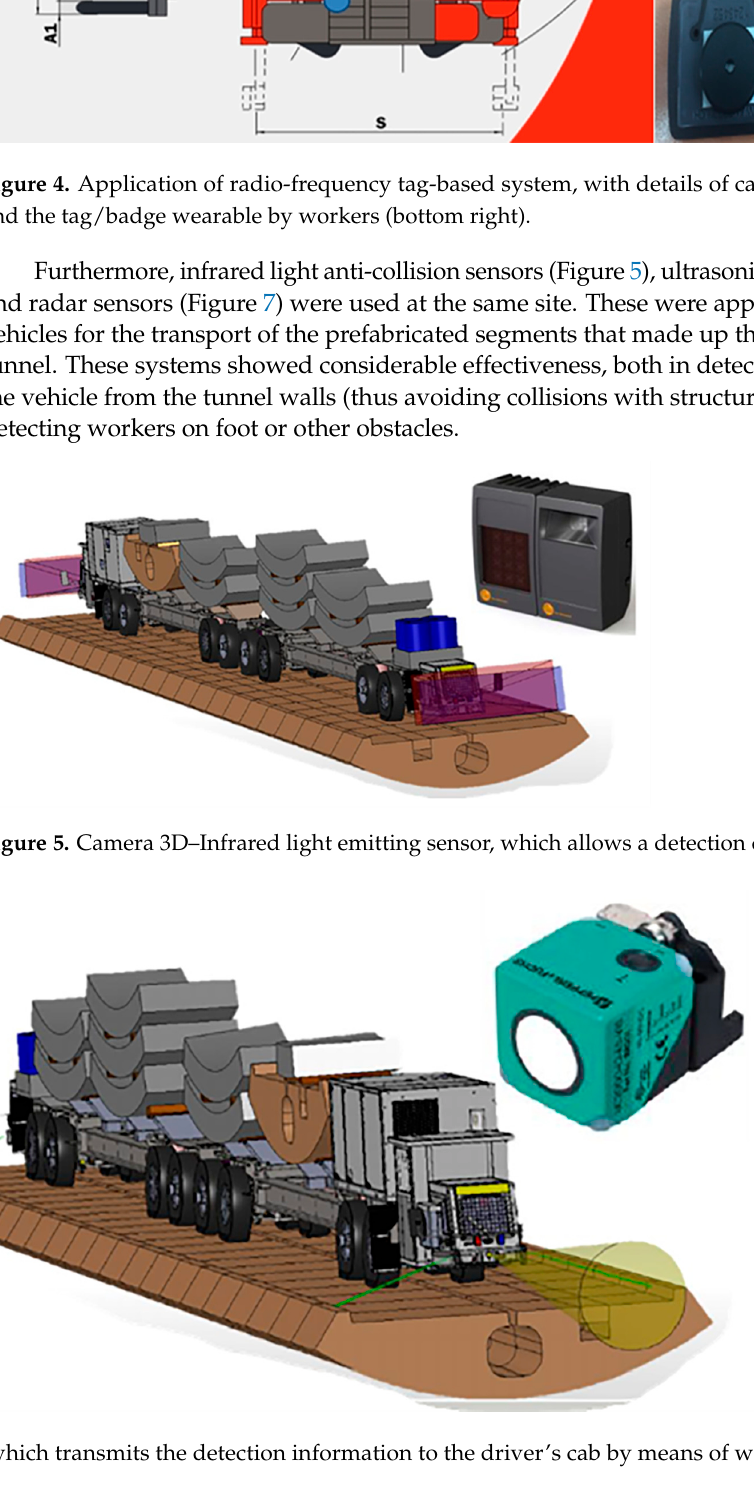
Figure 7. Radar positioned in front of the vehicle’s cockpit; detection distance of 24 m. 4. Discussion This study pointed out that RFID/RF—Radio Frequency Identification is the most widely used and is often implemented with other technologies. The less expensive technologies reported in the literature appear to be ultrasonic sen- sor-based systems and cameras, while lidar/laser systems are the most expensive and re- quire high maintenance. In general, the available anti-collision systems are currently used for large obstacles; however, in the future, it would be interesting to study suitable solutions to signal the presence of fixed or mobile obstacles to incoming vehicles resulting from exceptional sit- uations. Therefore, it would be of considerable use if any obstacle could be equipped with an emergency beacon. At the moment, the solution consists of a careful positioning of the structural components.